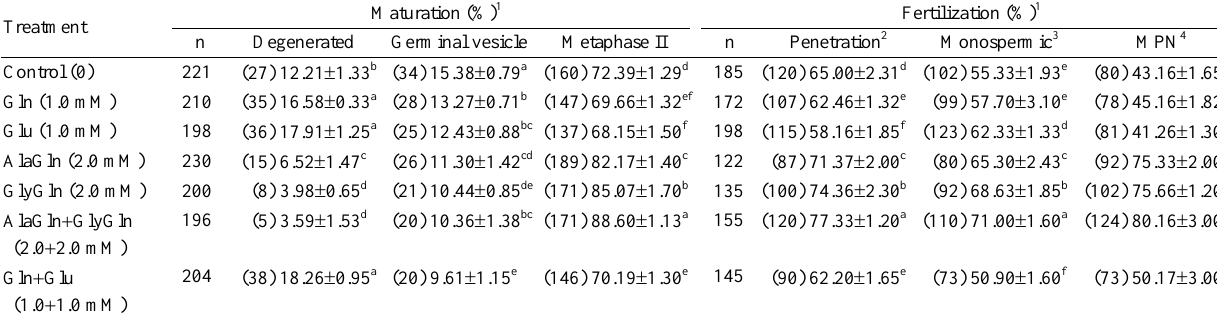
Table 1. Effects of glutamine (Gln), glutamic acid (Glu), L-alayl-L-glutamine (AlaGln), L-glycyl-L-glutamine (GlyGln) and their combinations on the percentage of maturation and fertilization of porcine oocytes Treatment